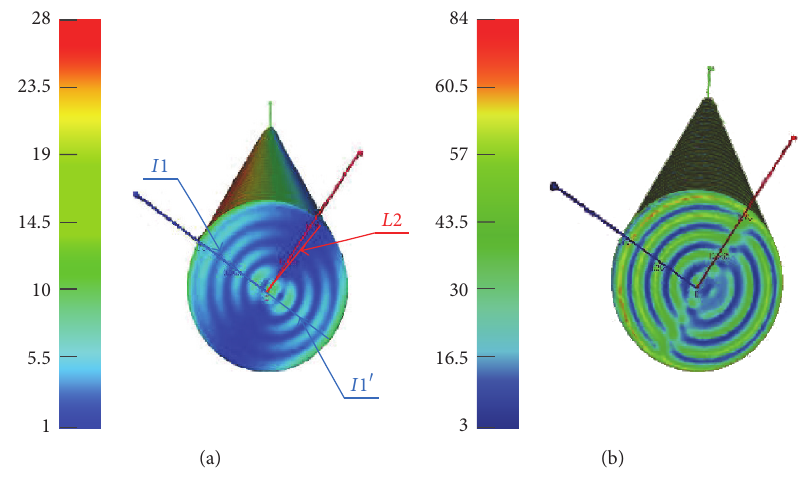
Figure 7: Currents on the bottom. (a) Amplitude; (b) phase.